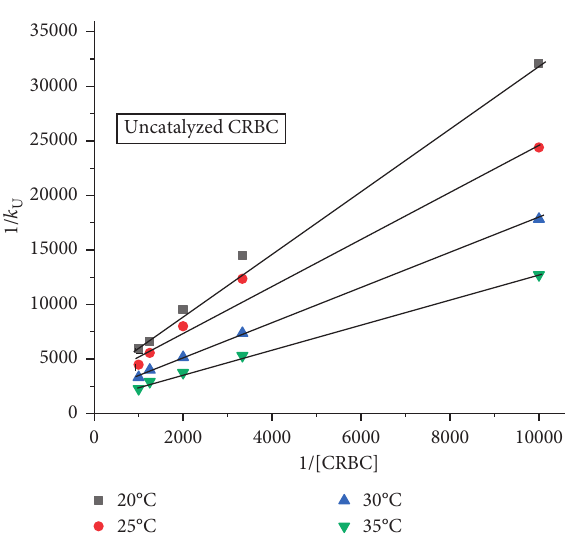
Figure 12: Plot of [1/ k